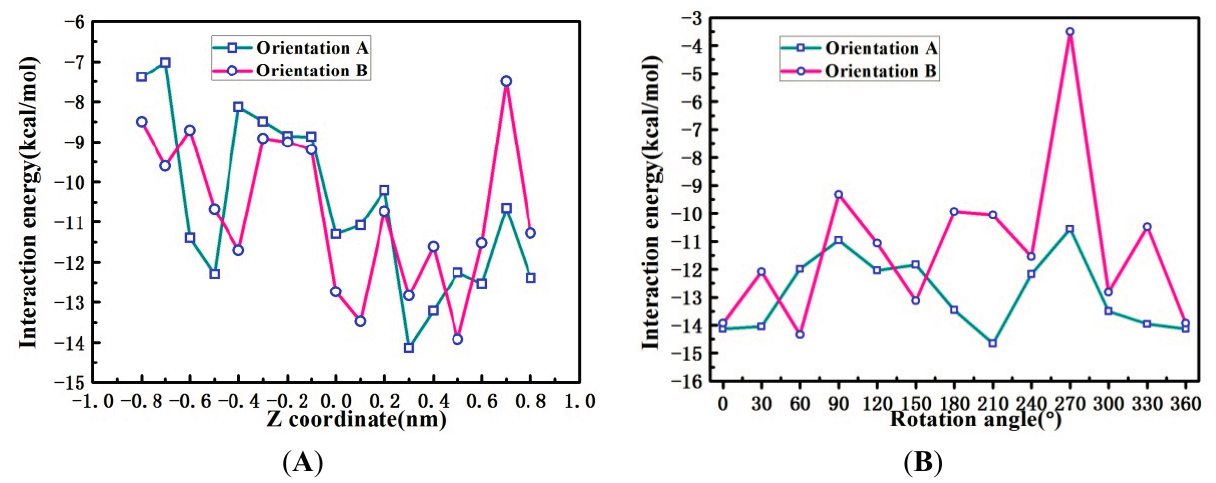
Figure 7. Interaction energies of the inclusion complexation of ILTG into the cavity of G 2 - β -CD at different ( A ) Z positions and ( B ) rotation angles in the gas phase by ONIOM (B3LYP/6-31+G(d):PM3)